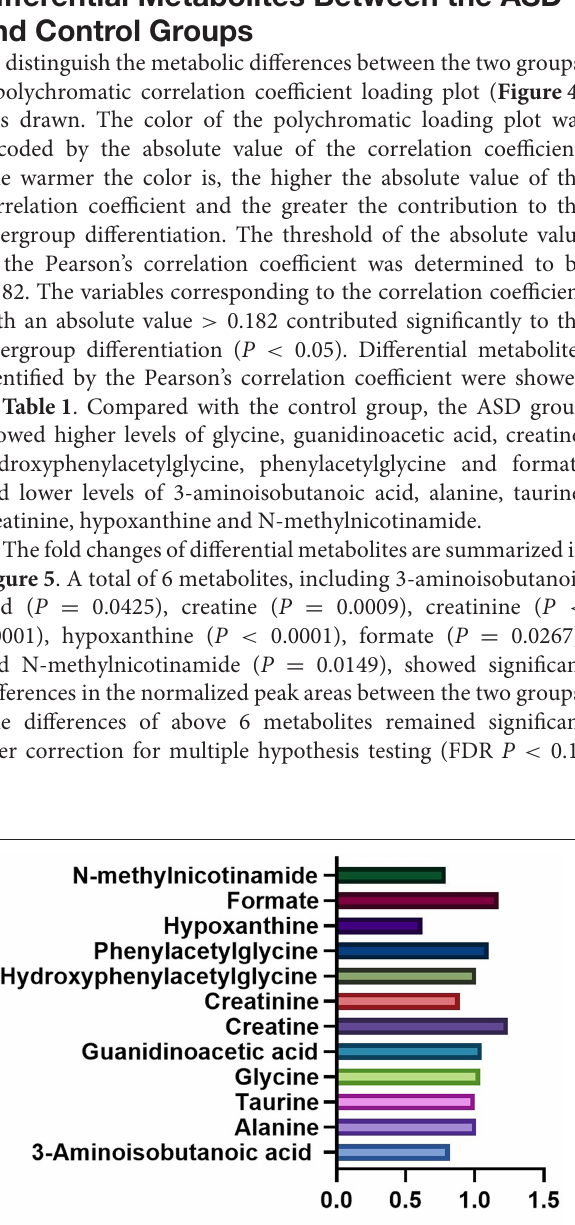
Supplementary Table 1 . A total of 39 metabolites were identified in the 1 H NMR spectra of urine samples.